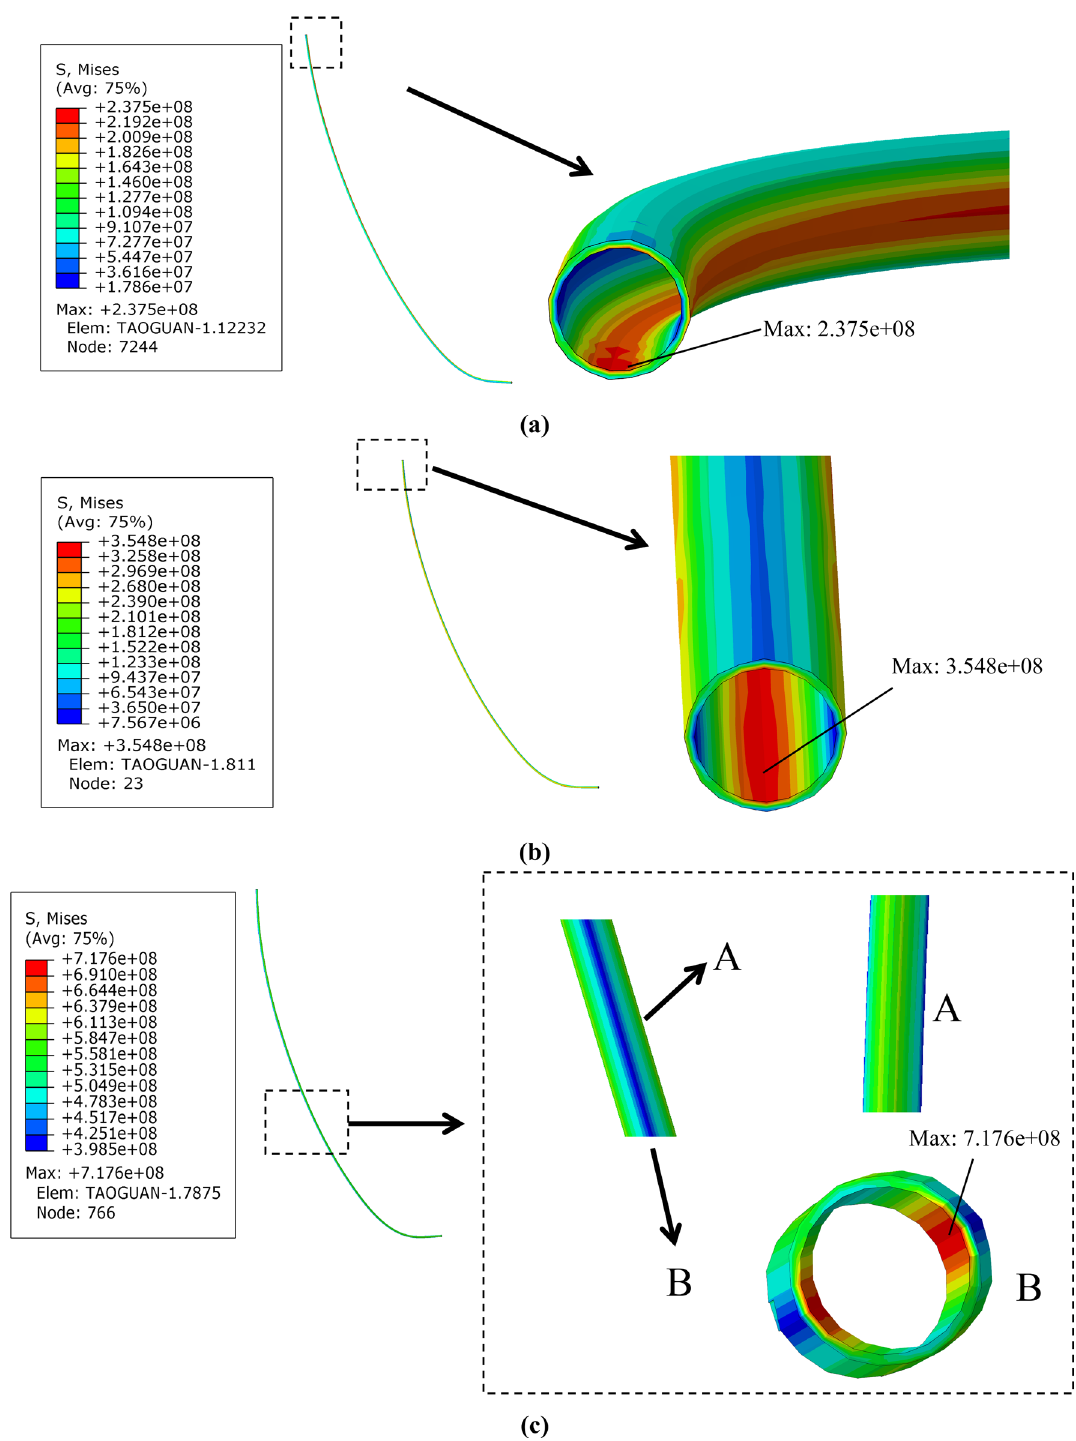
Fig. 11 Casing tensile stress cloud map of casing under different internal pressure. a No internal pressure. b Casing pressure, 60 MPa. c Casing pressure, 120